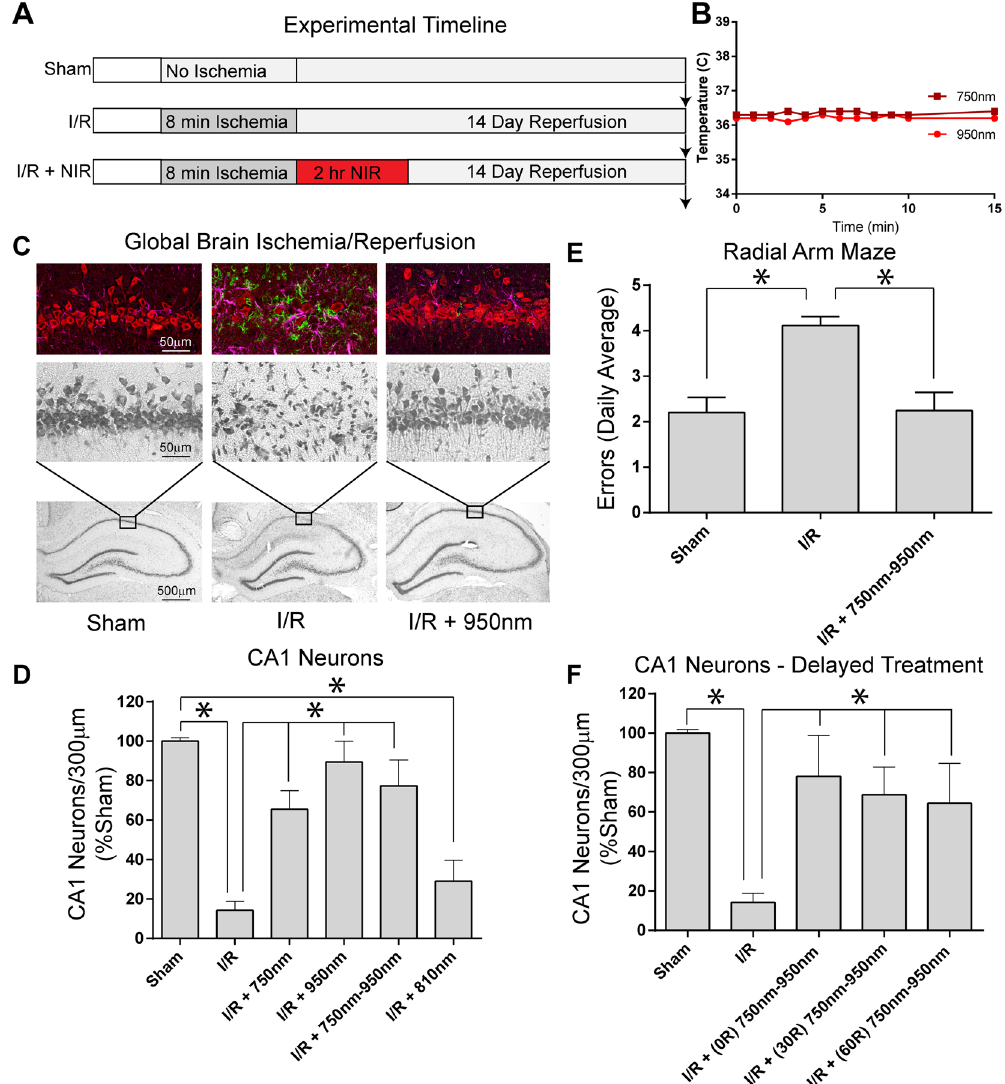
Figure 5. ( A ) Experimental timeline for NIR therapeutic trials. ( B ) Changes in brain temperature during NIR irradiation with LED diode. ( C ) CA1 hippocampal ischemia/reperfusion damage is robustly ameliorated upon NIR treatment during reperfusion. [bottom row] 10 × image of Cresyl violet stained hippocampus [middle row] 40 × magnification of CA1 hippocampus, [top row] Triple-label immuno-fluorescence for NeuN (red-neuron marker), Iba-1 (green-microglia/macrophage marker), and GFAP (magenta-astrocyte marker). [Left column] Sham-operated animal (Sham), [center column] 8 min ischemia followed by 14 days reperfusion (I/R), [right column] I/R plus NIR treatment (I/R + 950 nm). ( D ) Neuron counts in the CA1 hippocampus (mean ± SEM, n = 8–12 per group; * p < 0.05. ( E ) Radial arm maze performance (n = 10 per group; * p < 0.05 compared to sham). ( F ) Effect of delaying NIR treatment 30 or 60 min after reperfusion (30 R and 60 R; n = 6/group, * p < 0.05 compared to untreated I/R